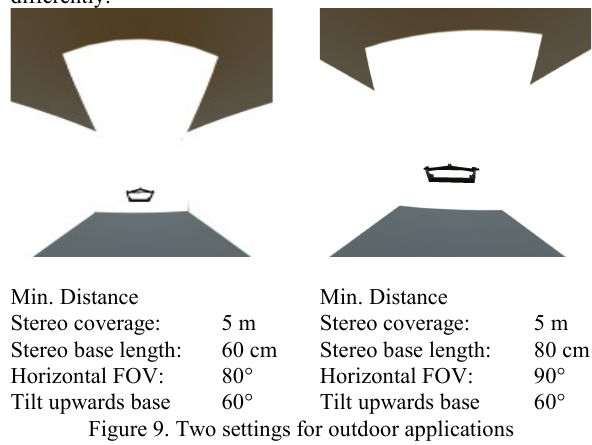
Figure 9. Two settings for outdoor applications Similar to the indoor application task, depending on the base